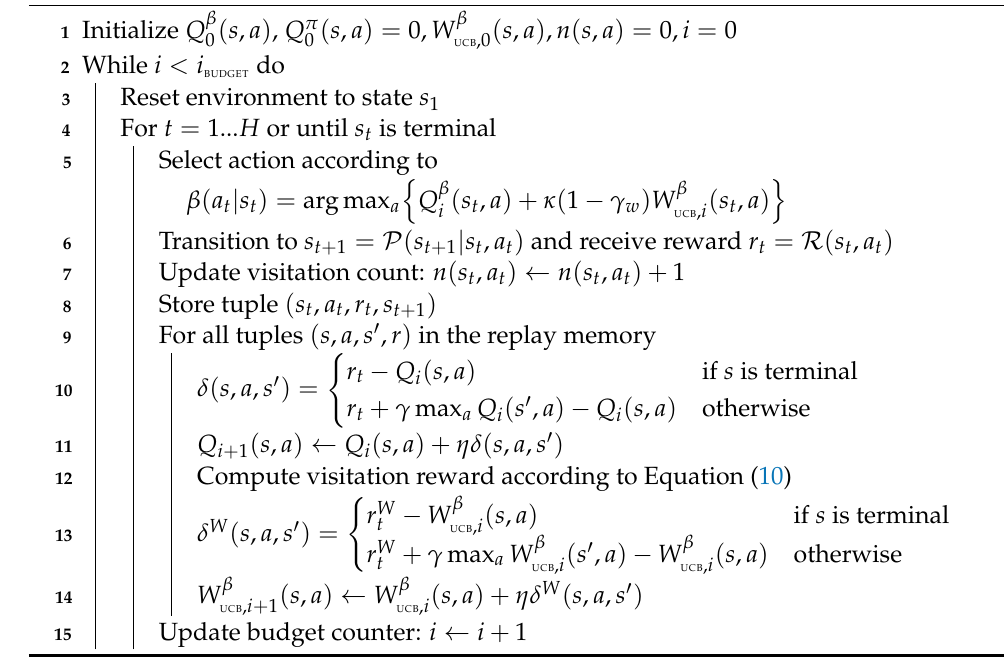
Algorithm A3: Tabular Q-Learning with Replay Memory and Visit. Value